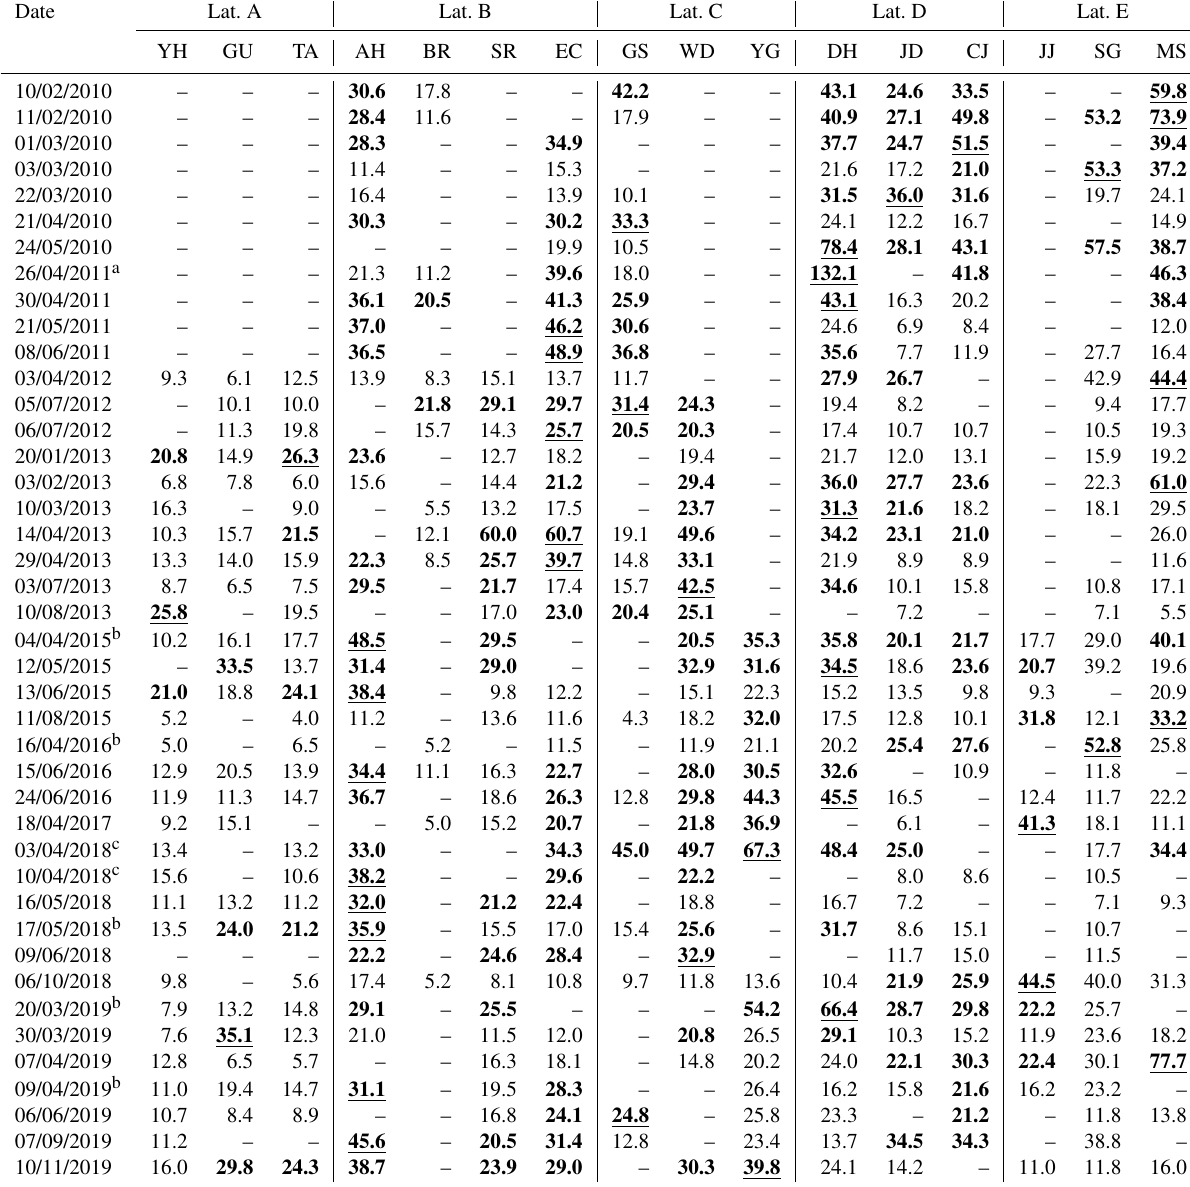
Table 1. Maximum wave height (cm) of the 42 pressure-forced meteotsunami events. The known events since 2010 are marked by a super- script. The event dates are presented in day/month/year format. The intensities exceeding the meteotsunami limit are denoted by bold text, and the highest intensity for each event is denoted by underlined text. Dash marks in the table indicate a date with less than 68% of available daily data at each tide